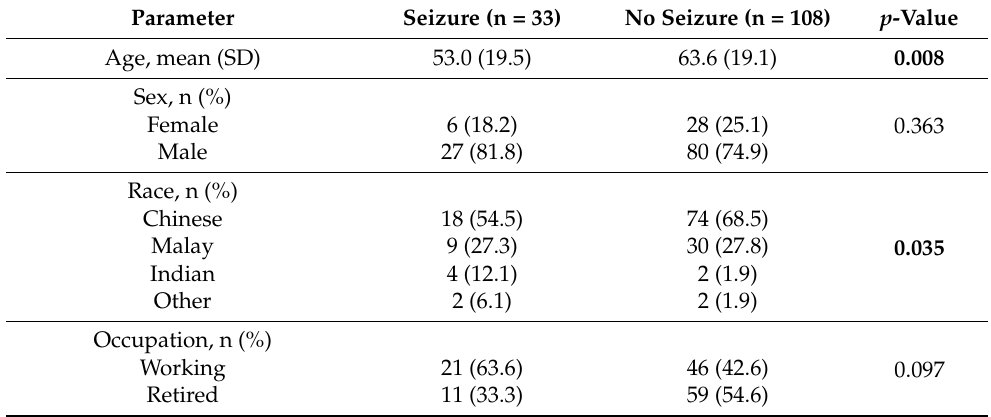
Table 1. Differing demographical and medical characteristics of patients with traumatic brain injury vis à vis seizure